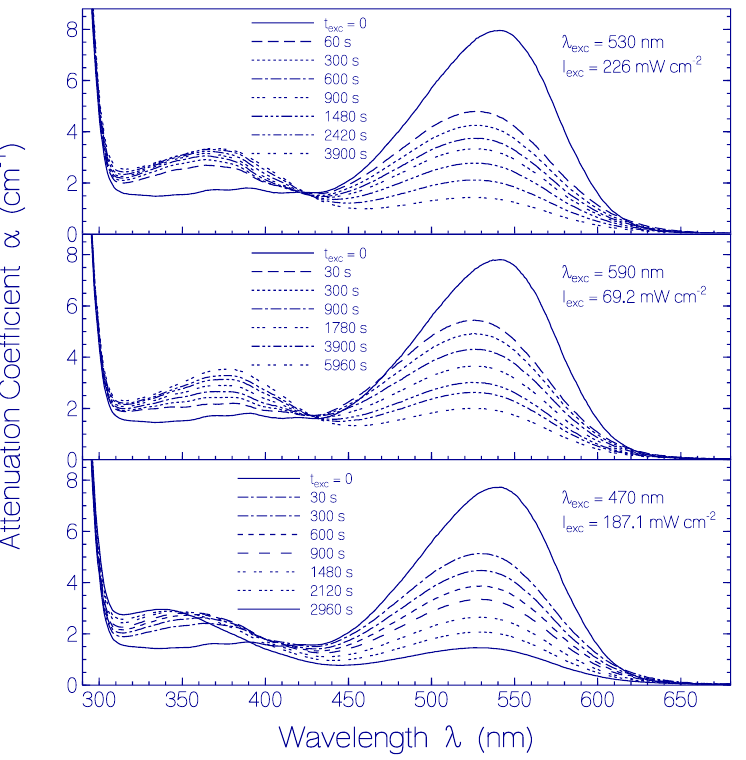
Figure 10. Development of attenuation coefficient spectra of CaRh in pH 7.3 HEPES/MOPS buffer in the light-adapted state during light exposure with LED 530 nm (top part), LED 590 nm (middle part), and LED 470 nm (bottom part). Input excitation intensities I exc and durations of light exposure t exc are listed in the sub-figures.